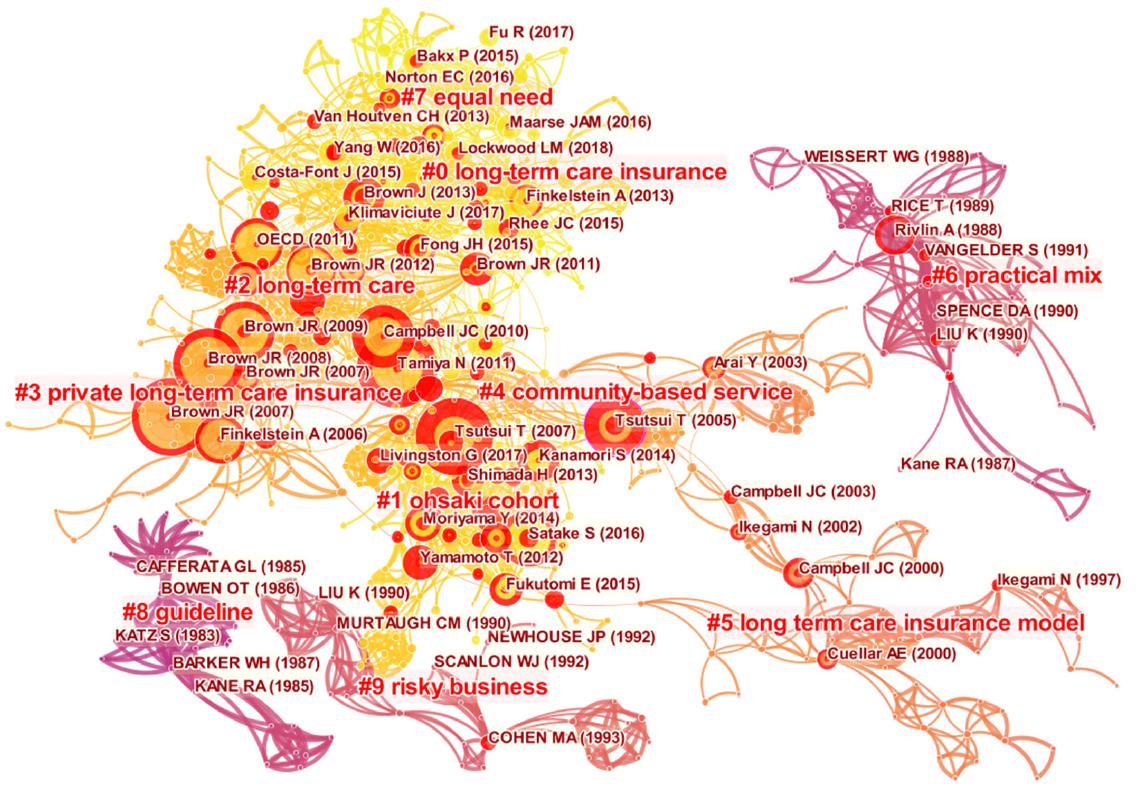
Figure 6. A visualization of the document co-citation network in LTCI research. Note: # represents a knowledge cluster.